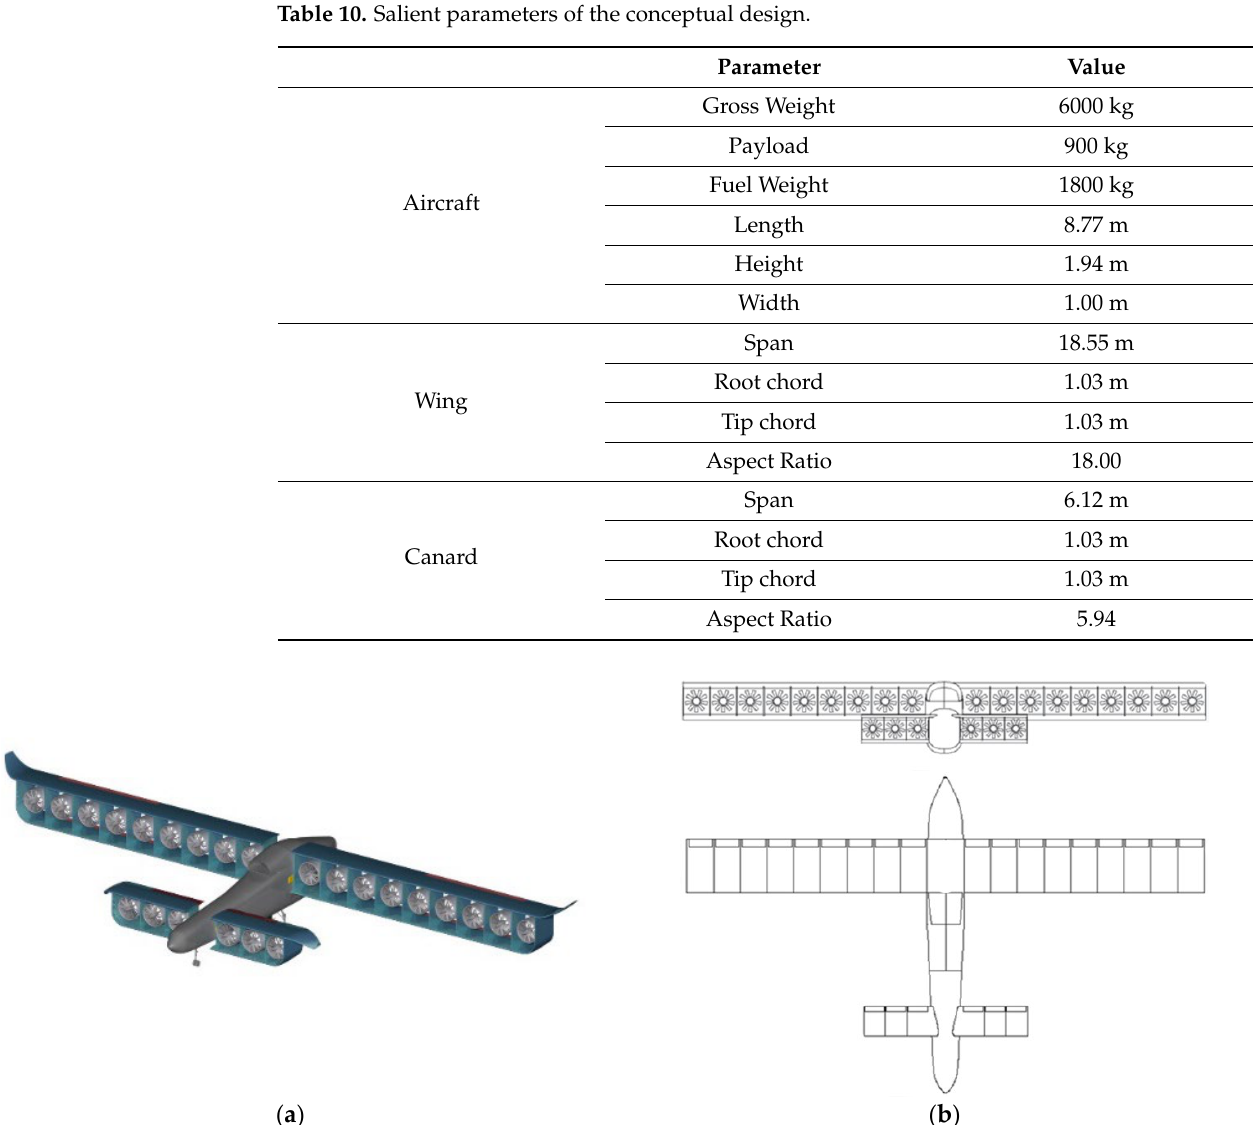
Figure 25. The conceptual design of the DEP eVTOL aircraft. ( a ) The isometric view; ( b ) the front and the vertical views.